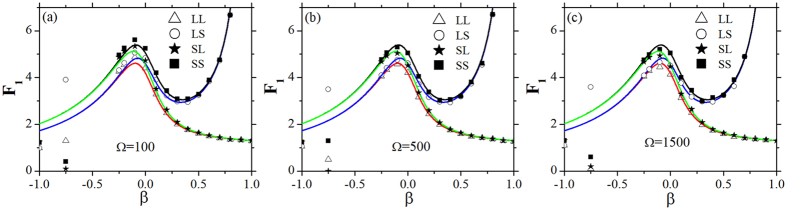
Fano factors of TCs as a function of β obtained by Langevin method20(lines) and Gillespie algorithm29 (symbols) with LL, LS, SL and SS feedbacks with different Ω.(a–c) α = 0.2, α2 = 0.3. All the parameters are measured in hr−1.